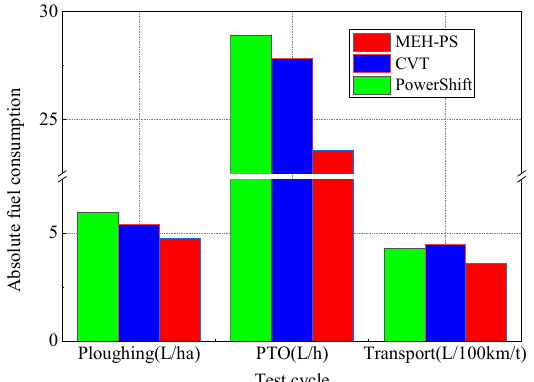
Figure 23. Comparison of fuel consumption of tractors equipped with different transmissions.